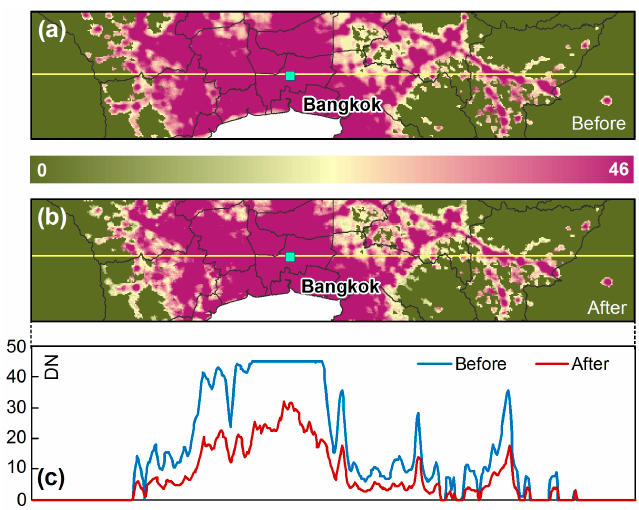
Figure 5. ( a ) Nighttime light before and ( b ) after variability enhancement over Bangkok and its surrounding areas; ( c ) shows profiles of pixel-level nighttime light brightness in the transect across corresponding areas.